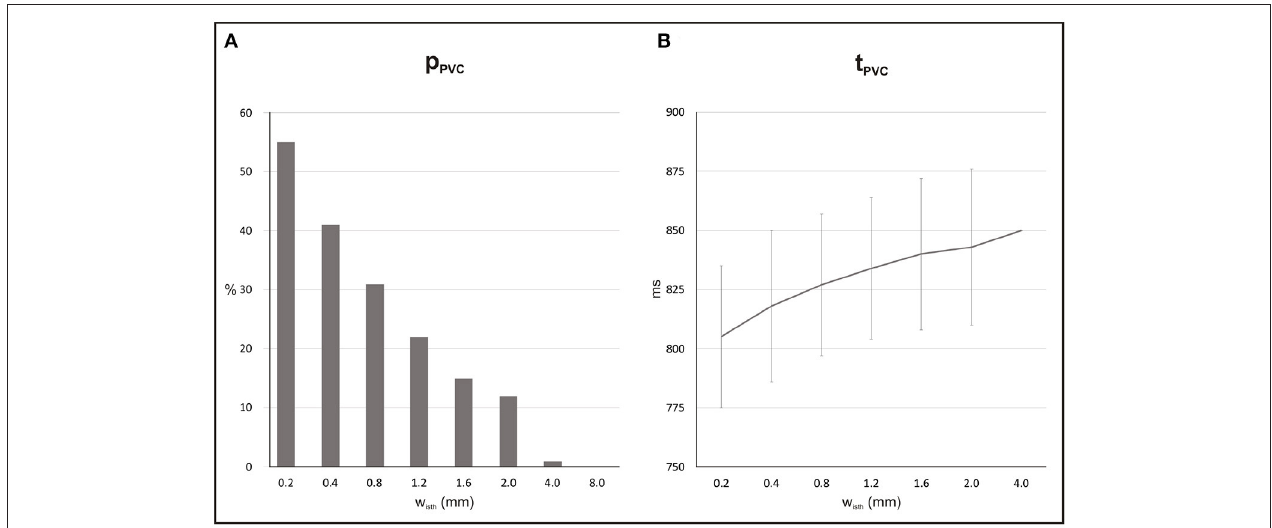
FIGURE 5 | Statistics of SCR-mediated PVCs in 2D sheets with different isthmus widths ( w isth ). (A) Probability p PVC of SCR-mediated PVCs. (B) Average waiting time t PVC .